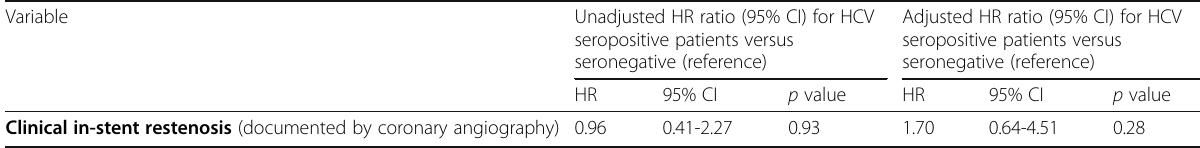
Table 9 Multivariate Cox hazard regression analyses for clinical in-stent restenosis at 12 months follow up Variable